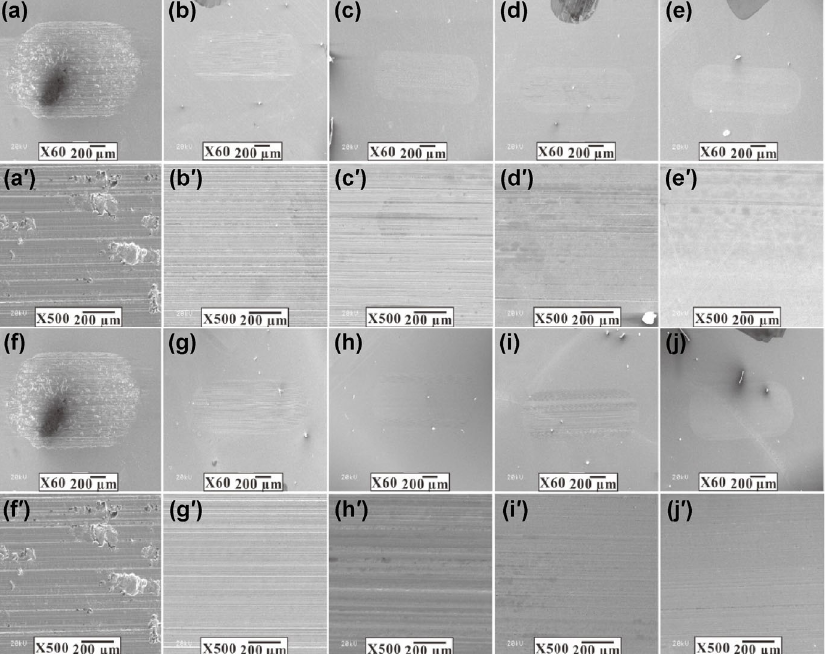
Fig. 4 SEM images of worn surfaces of steel disks lubricated by (a, a ′ , f, f ′ ) neat PAO10; mixtures with various mass concentrations of (b–e, b ′ –e ′ ) N 88816 S P and (g–j, g ′ –j ′ ) P 888S S P : (b, b ′ , g, g ′ ) 0.5 wt%, (c, c ′ , h, h ′ ) 1.0 wt%, (d, d ′ , i, i ′ ) 1.5 wt% , (e, e ′ , j, j ′ ) 2.0 wt%, test conditions: 300 N, 25 Hz and